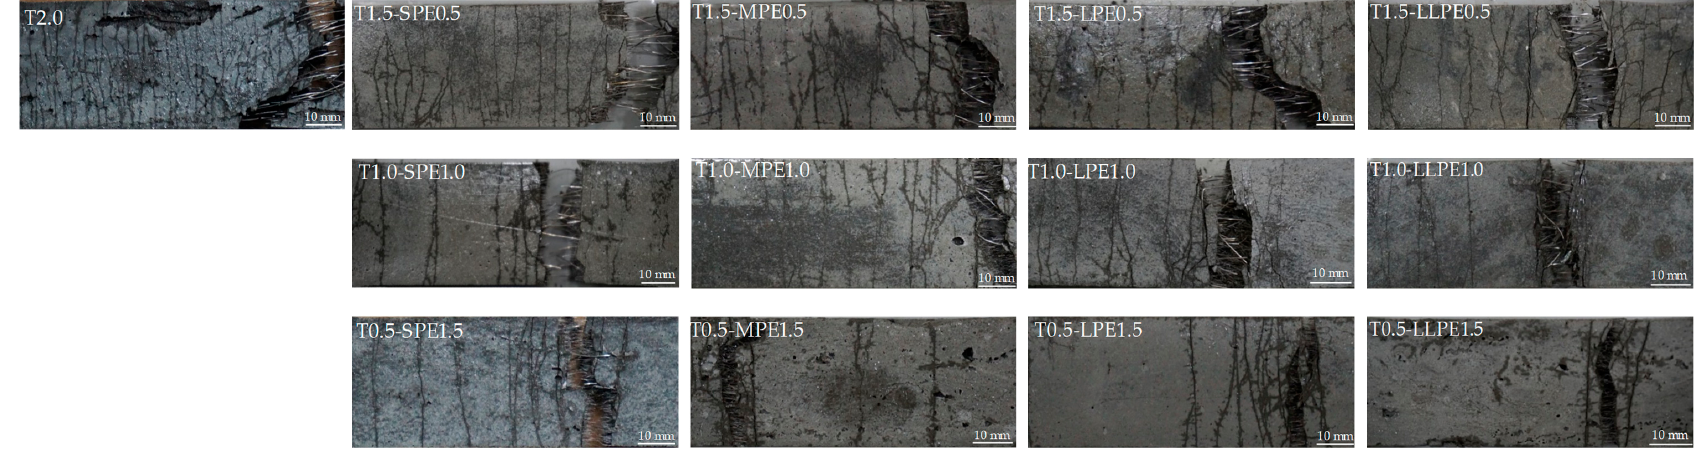
Figure 7. Micro-cracking behaviors of UHPCCs depending on fiber types and volume content.